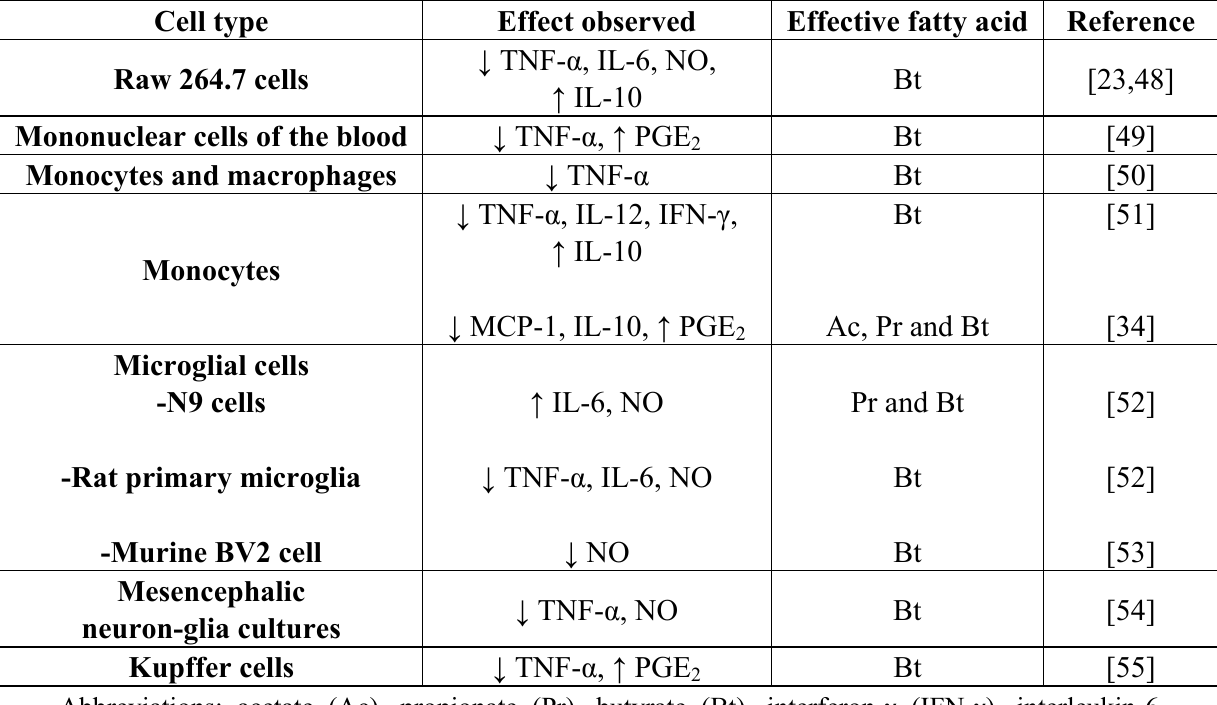
Table 1. Effect of SCFAs in the production of inflammatory mediators by isolated